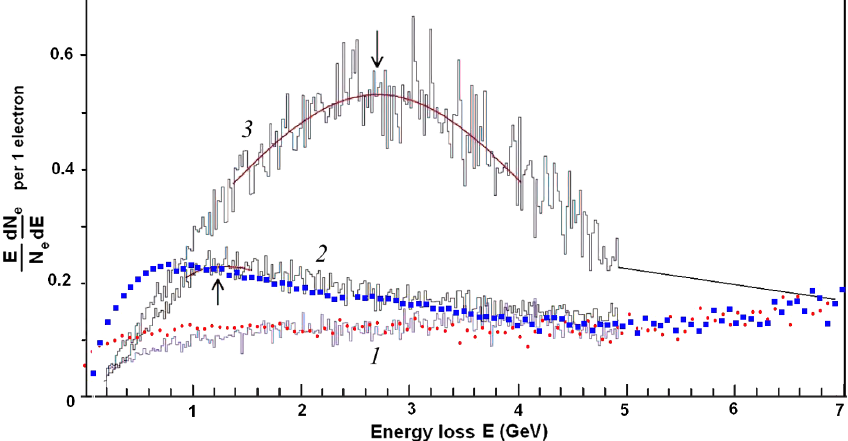
ring.FIG. 5. Measured distributions of energy losses of 7 GeV electrons in the multistrip device: the curves 1, 2 and 3 are for the cases of nonoriented, planar orientation and axial orientation, correspondingly. The red points and blue squares are calculation for nonoriented and planar oriented